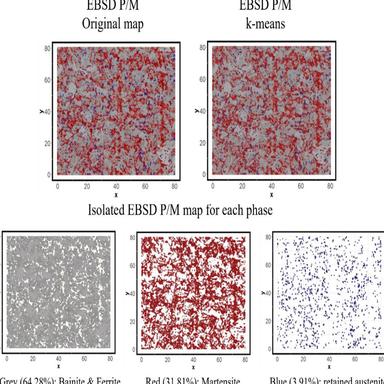
EBSD P/M original vs clustered map and individual P/M maps for each structural phase. X and Y coordinates are presented in µm.